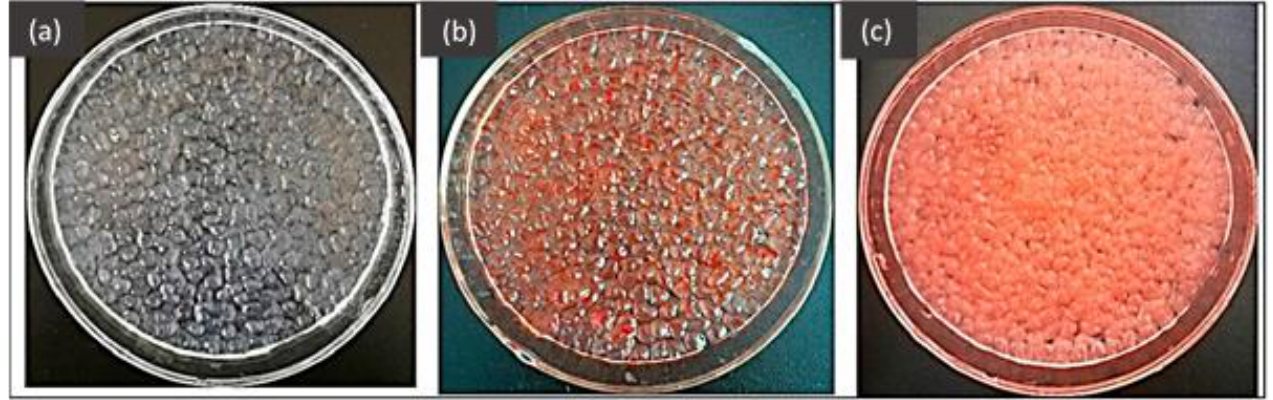
Figure 4. Images of the prepared beads: ( a ) beads without PS/DOX, ( b ) beads containing PS/DOX and ( c ) beads containing Pch/PS/DOX [62], reproduced with permission from Elsevier.